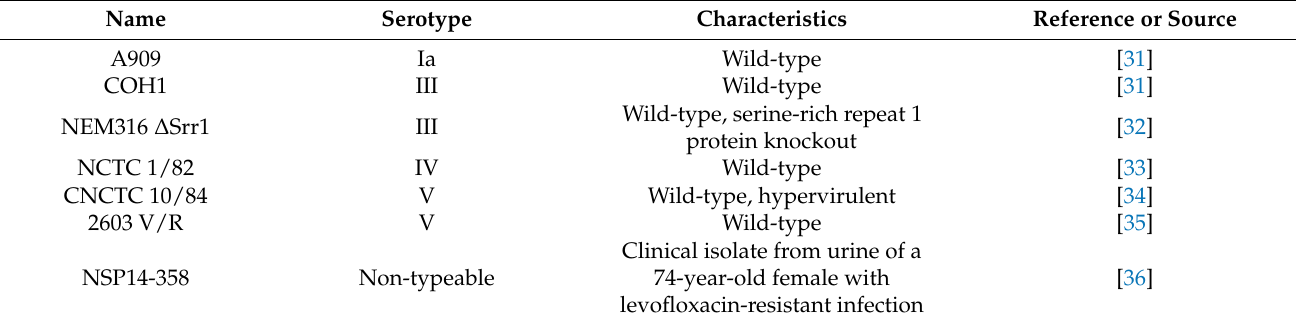
Table 1. Group B streptococcus strains used in this